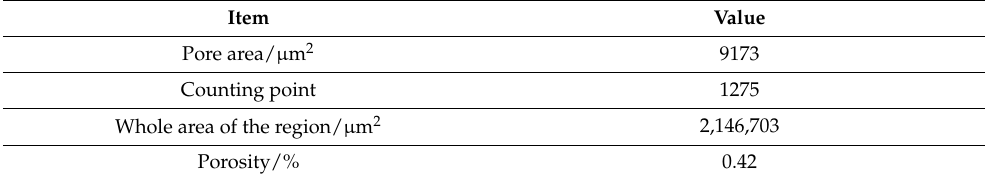
Table 4. Calculation of porosity of the